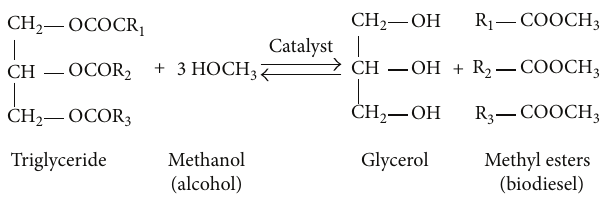
Figure 2: Transesterification reaction mechanism (R 1 , R 2 , and R 3 are long chain hydrocarbons, sometimes called fatty acid